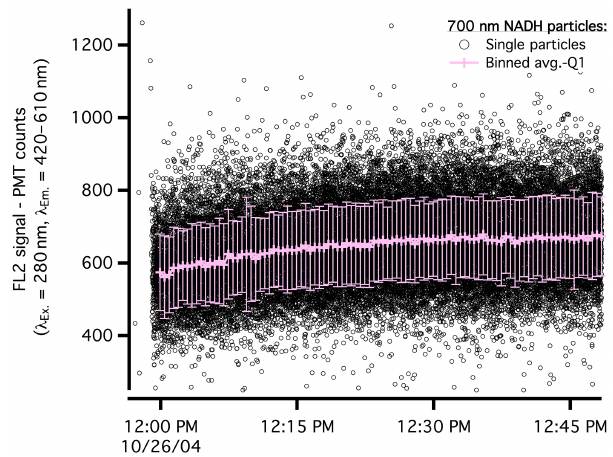
Figure 9. Time series from an example NADH calibration exper- iment, illustrating the lack of stability in the NADH fluorescence signal over ∼ 1h timescales. Signal from the FL2 detector is plot- ted on the y axis for individual particles (black data points) and 1min averages (pink line with error bars representing the standard